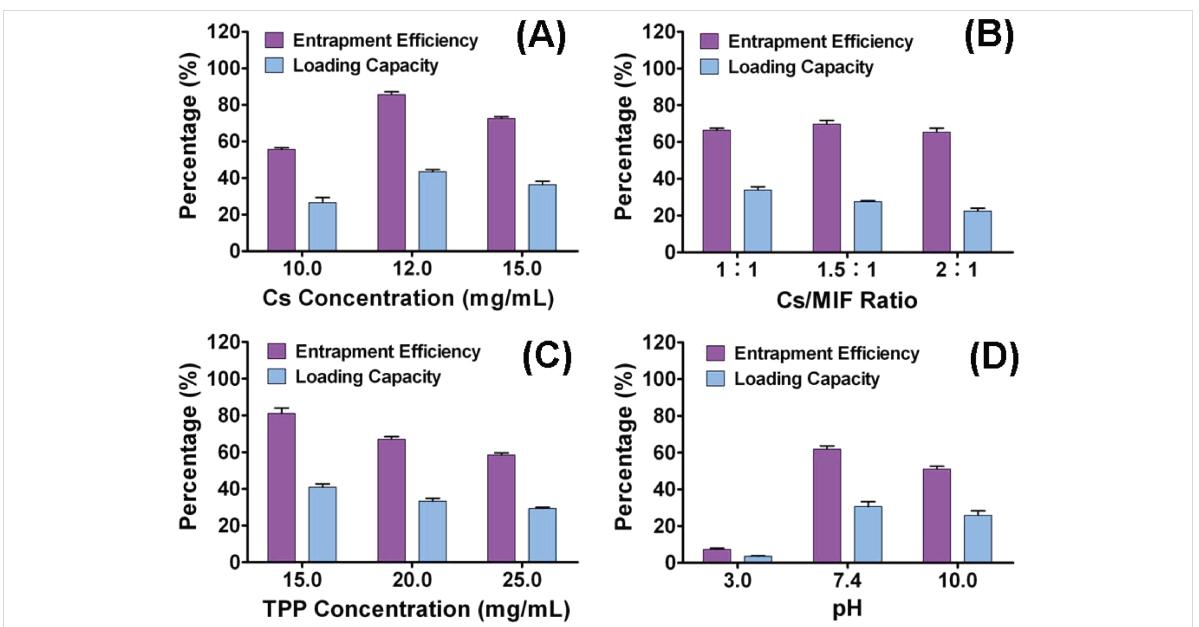
Figure 2: The influence of the preparation conditions including Cs concentration (A), Cs/MIF mass ratio (B), TPP concentration (C), and pH of TPP solution (D) on the encapsulation efficiency (EE) and drug loading capacity (DL) of MCNs. The optimum preparation conditions are: Cs concentration of 12 mg/mL, Cs/MIF mass ratio of 1:1, TPP concentration of 15 mg/mL, and TPP solution pH 7. When a parameter is changed, the other variables are selected with the optimum conditions.